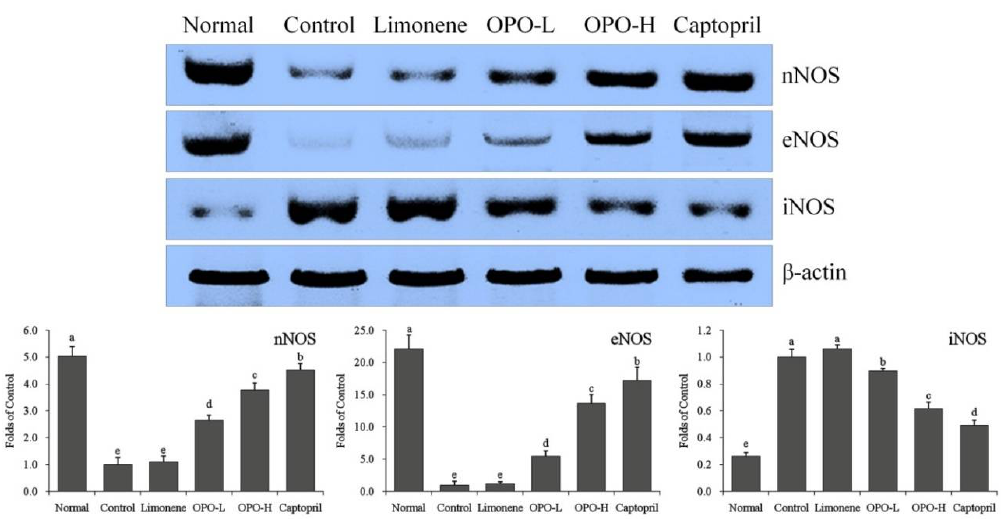
Figure 8. Protein expression levels of nNOS, eNOS and iNOS in rat myocardial tissue. For each group, n = 10 rats. a–e Bars with different letters in the chart are significantly different ( p < 0.05) according to Duncan’s multiple range test, and the same letter indicates that the values are significantly different. OPO-L, orange peel oil low dose, 5 mL/kg bodyweight (bw); OPO-H, orange peel oil high dose, 10 mL/kg bw; captopril, 15.6 mg/kg bw; and limonene, 10 mL/kg bw.